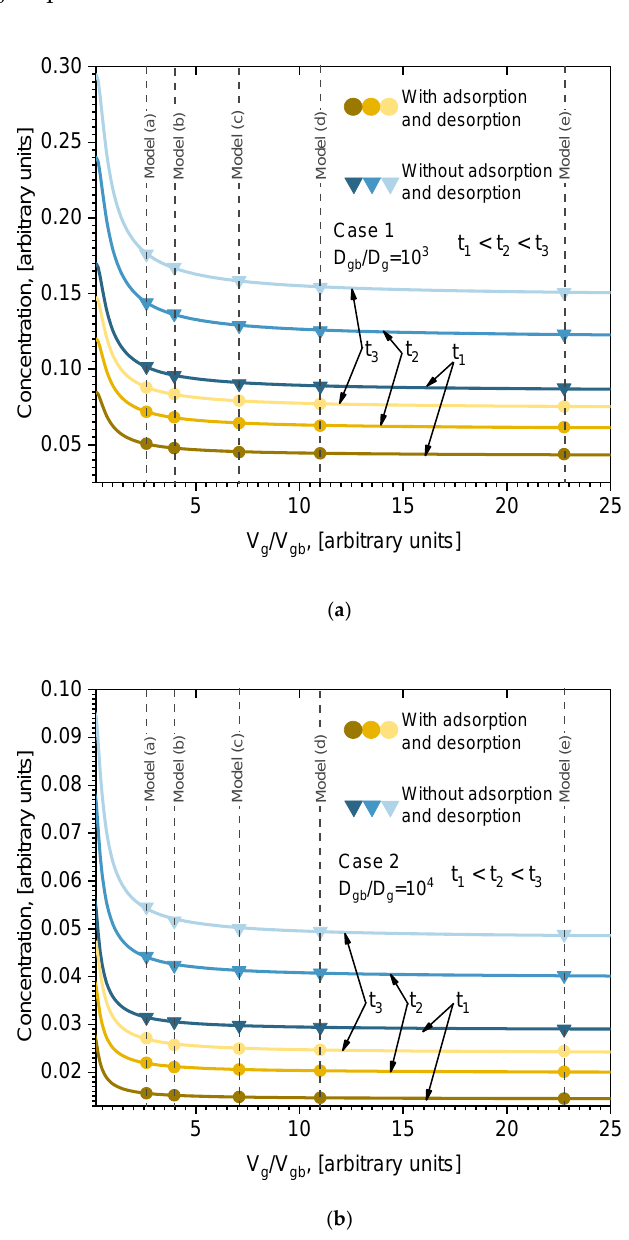
Figure 8. Average concentration dependencies (points) on relative volume V g /V gb at different moments of time and for cases with and without adsorption / desorption. Lines are fitting results using the error function in Equation (8): ( a ) Case 1; ( b ) Case 2.